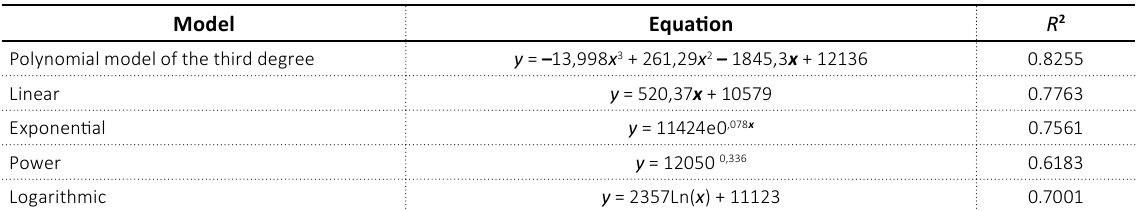
Table 3. Coefficients for determining the trending